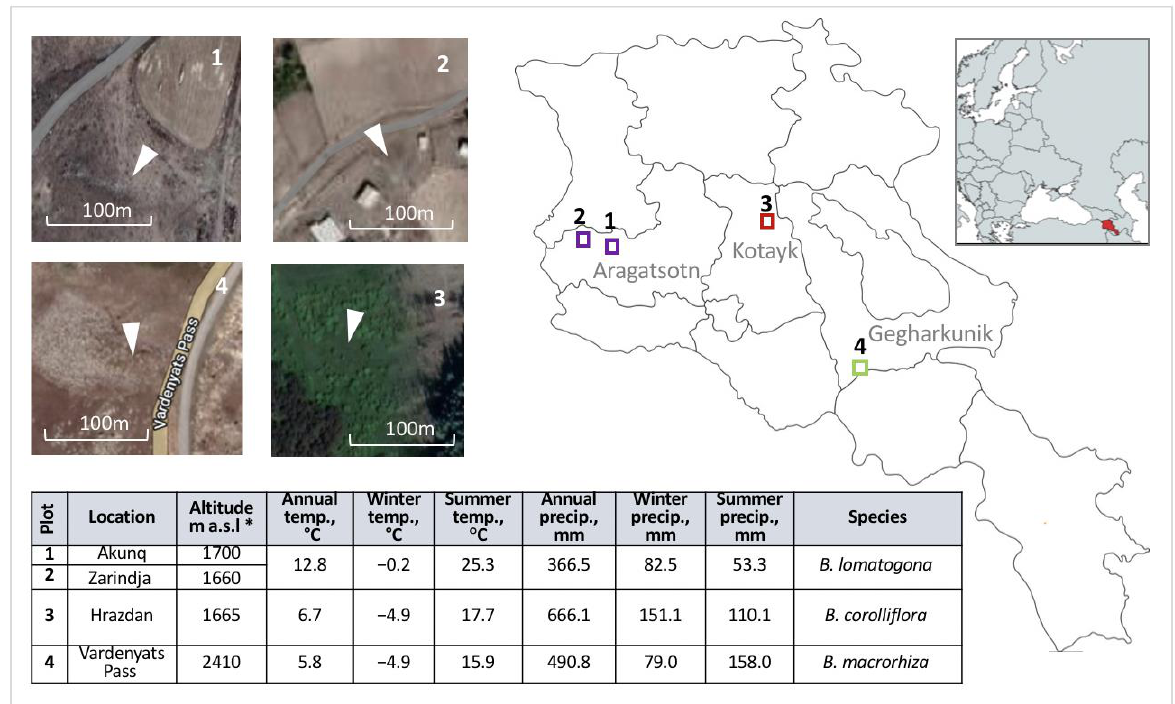
Figure 2. Study area and sampling localities (Plots 1, 2, 3 and 4) for annual monitoring of the wild beet species in 2016–2021 and climate parameters of the selected regions for the period of 2010–2020. * meters above sea level.